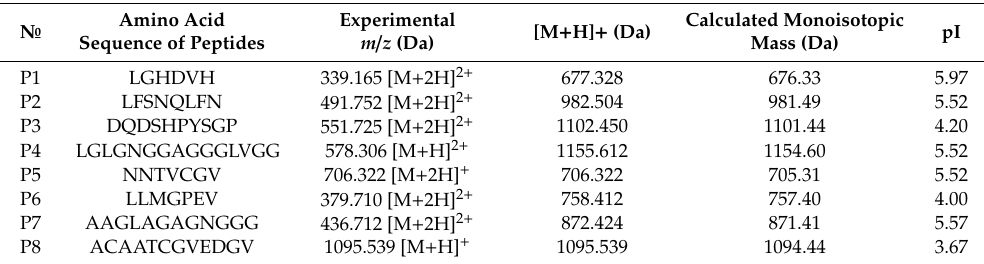
Figure 4. MALDI-MS / MS spectrum of fragmented peptide at m / z 1095.53 Da (positive ion mode). Table 2. Amino acid sequence of several peptides in the fraction below 1 kDa, identified by tandem mass spectrometry.